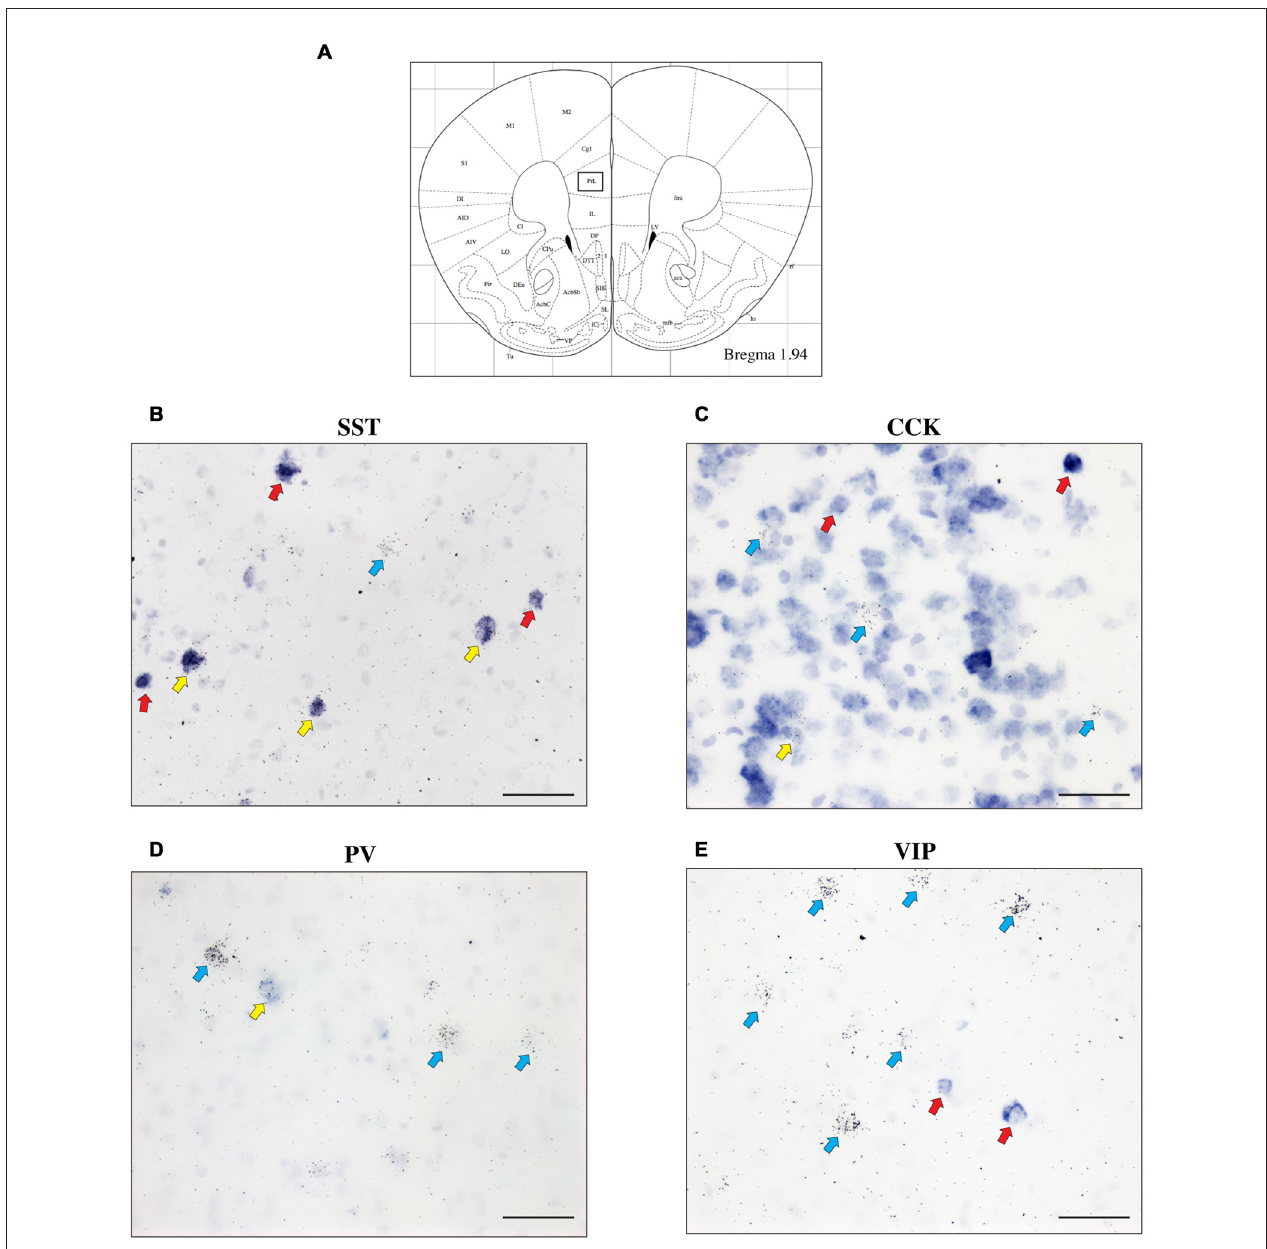
FIGURE 3 | The expression of CRH-BP mRNA in various GABAergic interneuron subtypes in the PFC. Coronal section from the Paxinos and Franklin (2001) mouse brain atlas (A) at Bregma coordinate 1.94 mm, highlighting the prelimbic region of the PFC where the images in (B–E) were captured. High magnification bright field images show a high degree of colocalization between CRH-BP and somatostatin (SST) mRNA (B) and a lower degree of colocalization between CRH-BP and cholecystokinin (CCK) (C) , parvalbumin (PV) (D) and vasoactive intestinal peptide (VIP) (E) in the prelimbic PFC. Cells labeled for CRH-BP only (silver grains) are indicated with blue arrows, examples of cells labeled for SST, CCK, PV, or VIP only (purple digoxigenin signal) are indicated with red arrows, and dual-labeled cells are indicated with yellow arrows. Images shown are from prelimbic cortical layers II—V (B) , I—III (C) , V and VI (D) and I—III (E) . Midline is on the ride side of panels (B–E) . Scale bar: 50 µ